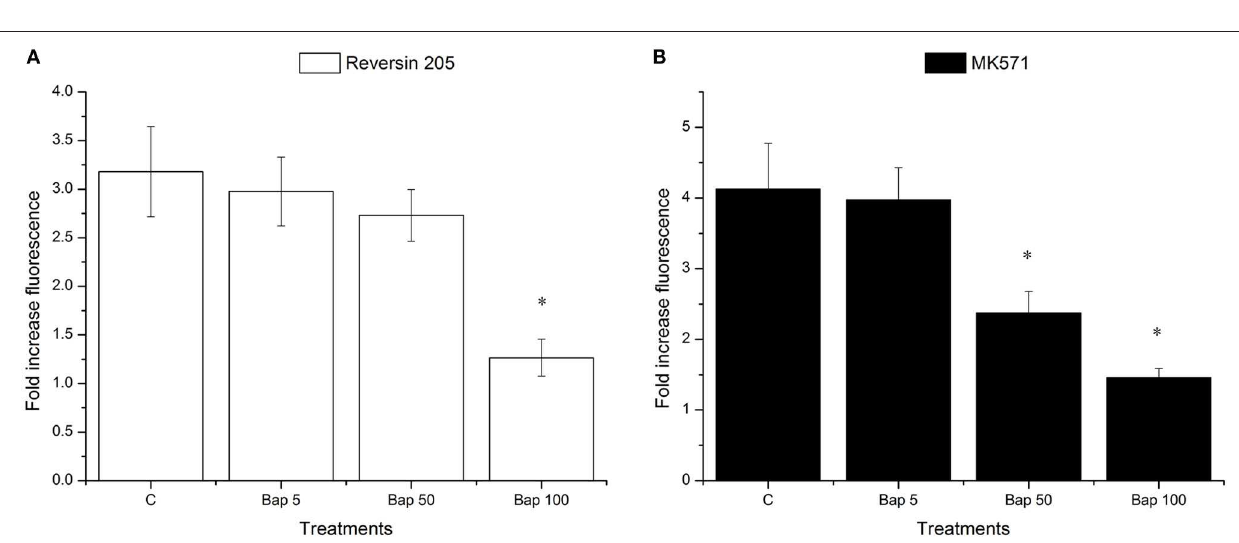
FIGURE 6 | Fold changes in the Ca-AM fluorescence intensities of M. coruscus gills after treatment with ABCB1 inhibitor reversin 205 (A) or ABCC inhibitor MK571 (B) . Data are presented as mean ± S.D ( n = 3 per group). Each bar represents the fold increase of fluorescence level compared to control group. Asterisks indicate the significant differences in fluorescence intensities between control and treatment groups (* P < 0.05). high expression of ABCB1 induced by Bap was observed in